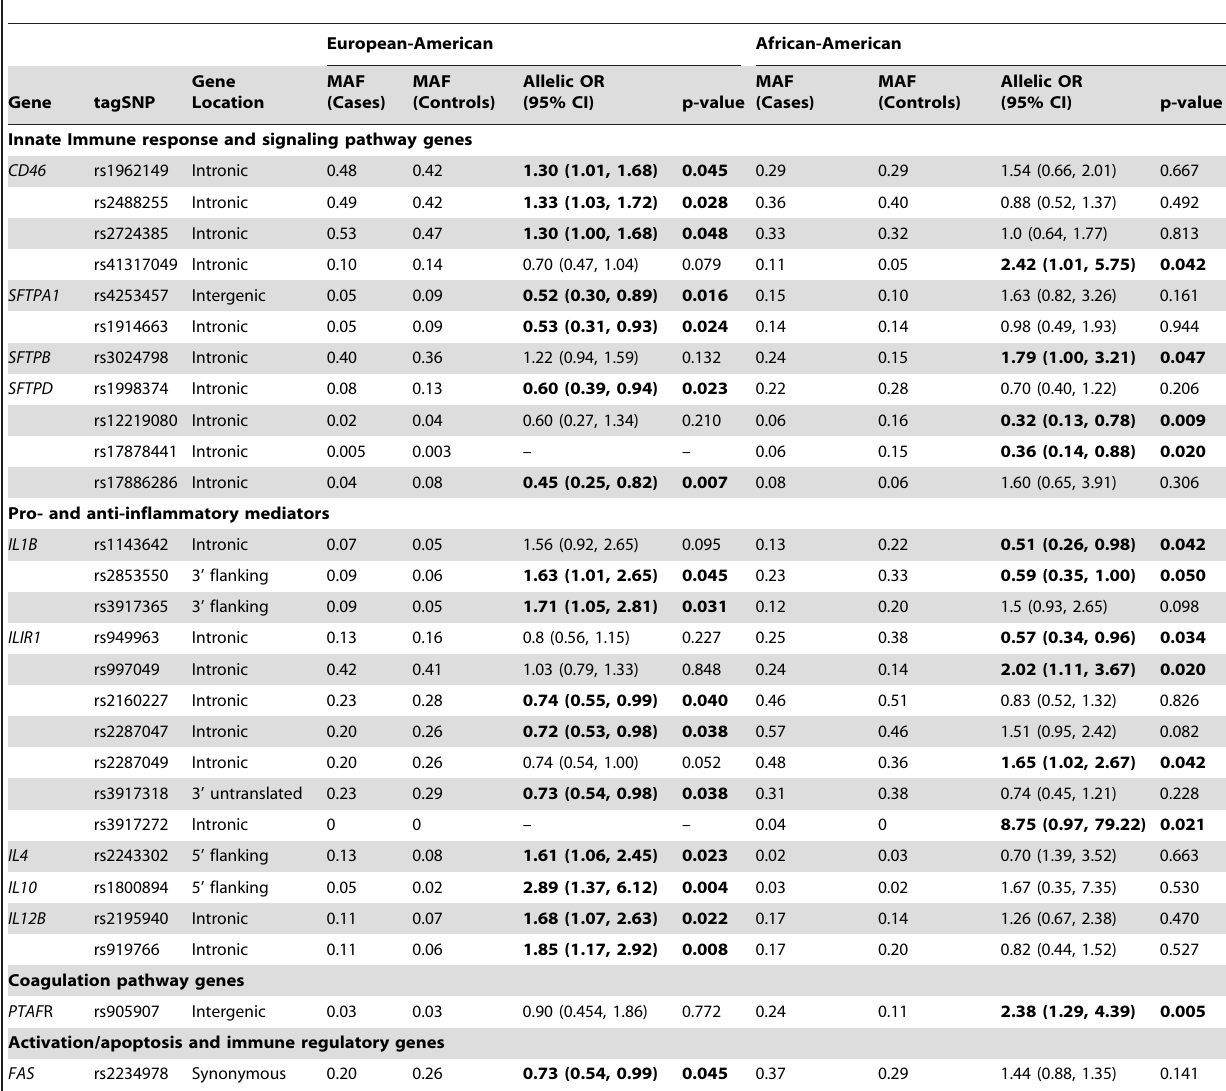
Table 3. Summary of tagSNPs associated with IPD in European-Americans and/or